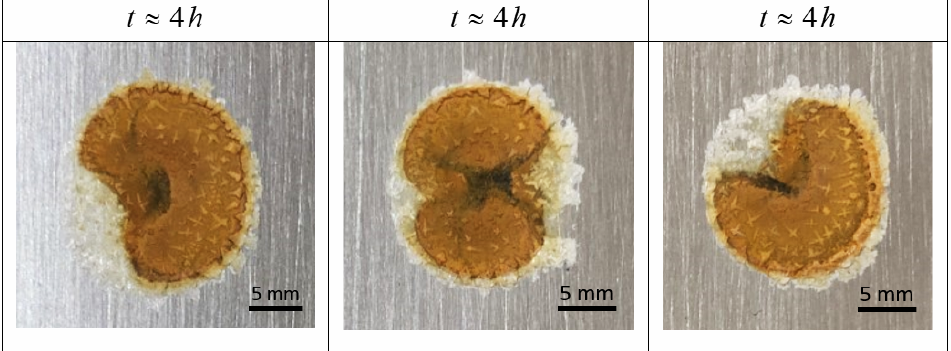
Figure 3. Oxide stain and salt crystals in a dried Evan’s drop experiment after 4 h at room tempera- ture.